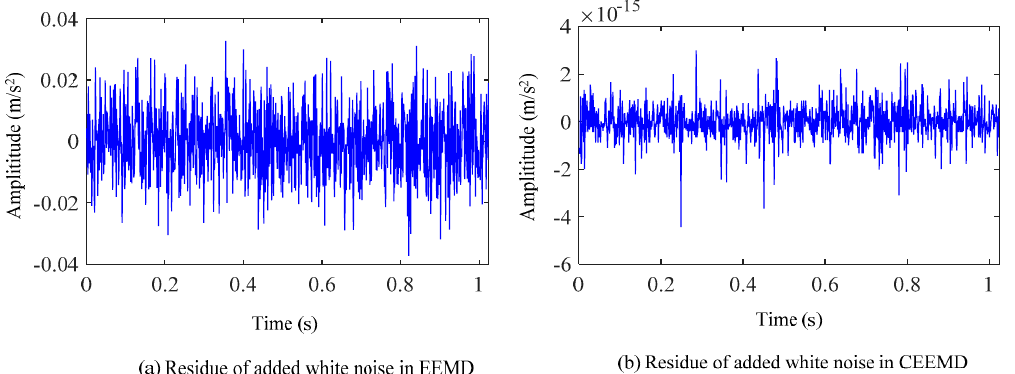
Figure 9. Residues of added white noises derived by EEMD and CEEMD.